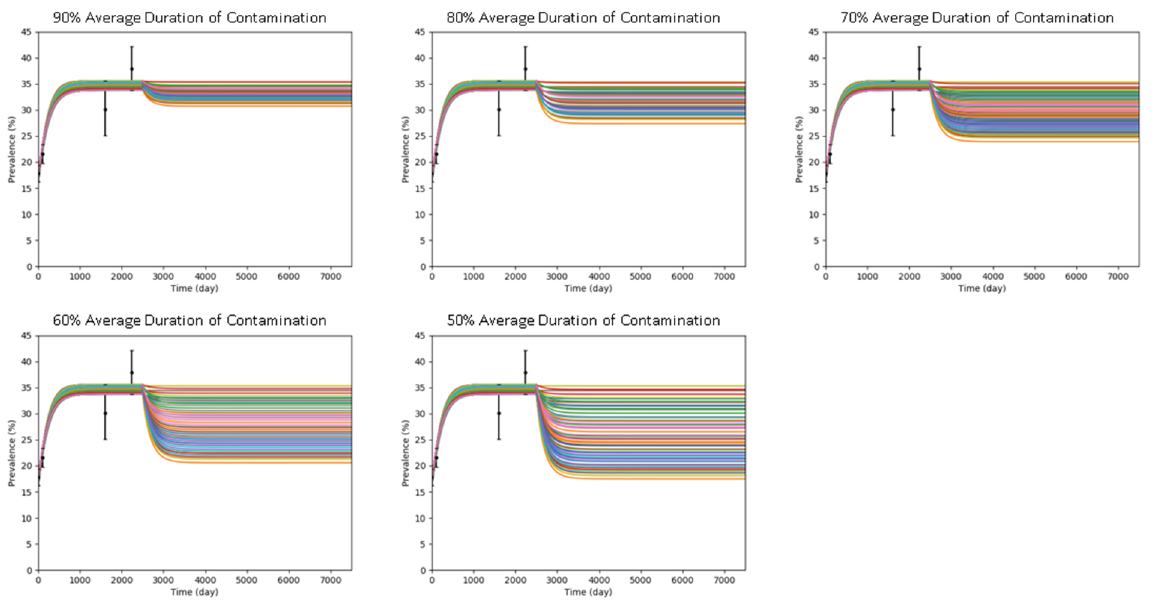
Figure 1. Plots of effect of five levels of hand-hygiene compliance to MRSA colonization prevalence. Hand-hygiene compliance interventions were implemented on Day 2501.